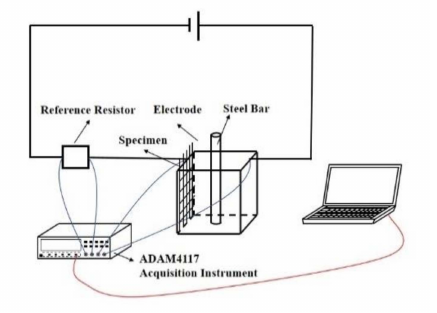
Figure 3. The schematic diagram of DC electrical resistance measurement.